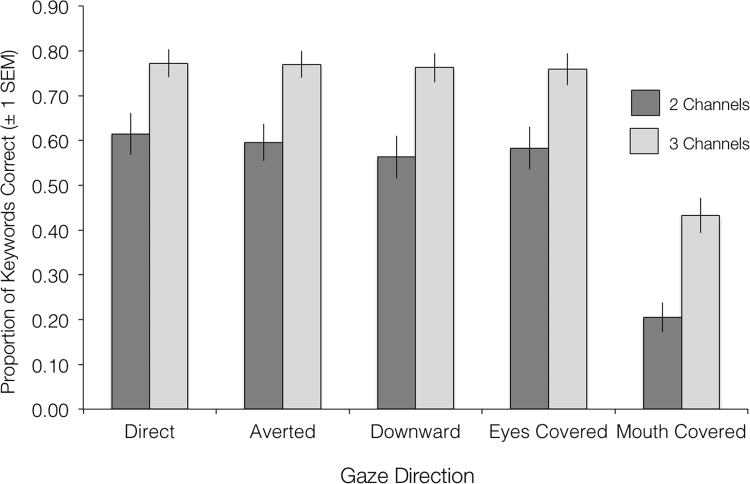
Plot of mean group accuracy (±1 S.E.M.) on a test of sentence report, across the factors Visual Condition and Auditory Clarity.